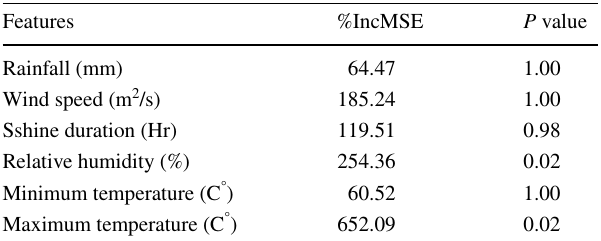
Fig. 5 Summary of agreement between observed and predicted PET at validation phase based on scatter and time series plot Table 2 Statistical evaluation of important climate parameters in pre- dicting